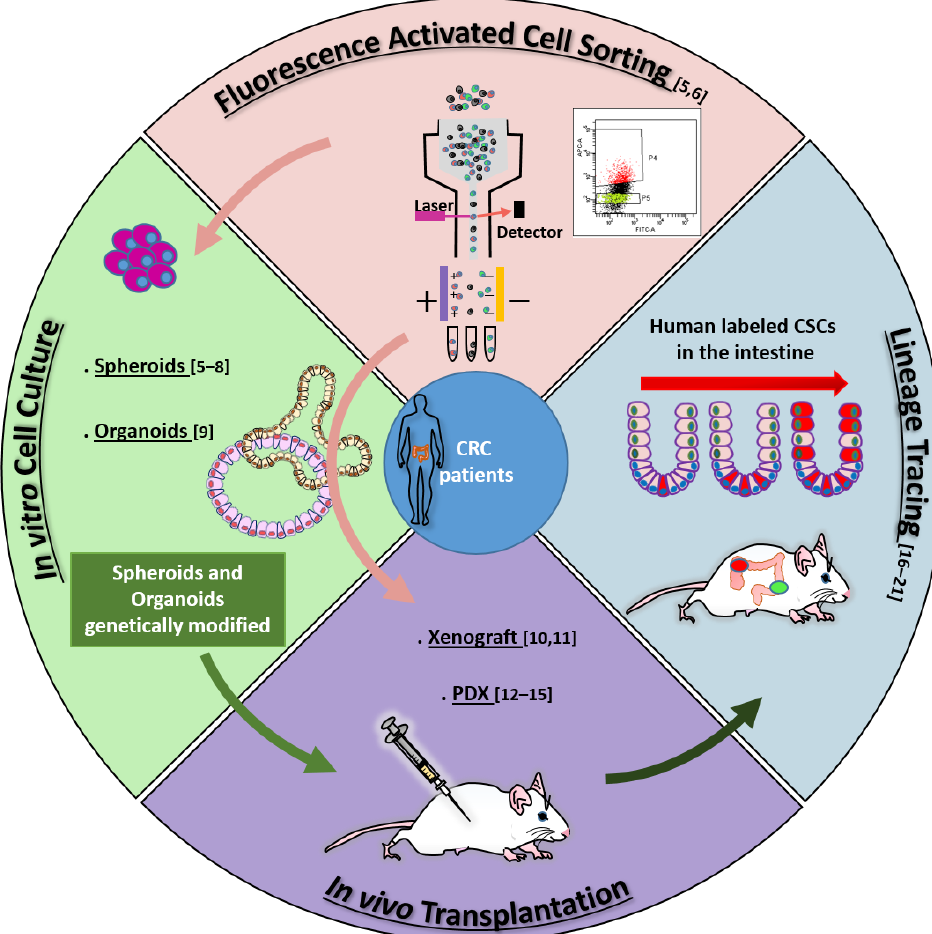
Figure 1. Main methodologies contributing to cCSCs definition: fluorescence-activated cell sorting (FACS) [5,6]; in vitro cell culture [5–9]; in vivo transplantation [10–15]; lineage tracing [16–21]. Ar- rows across sectors identify the complementary application of different techniques: For example, identification of cCSCs by cell sorting can be validated by in vitro cell culture and/or by in vivo trans- plantation assays (pink arrows); Xenografting is often performed with cultured and/or genetically labeled cCSCs (light green arrow); human cCSC lineage tracing is mostly performed by transplanting cCSCs previously genetically manipulated in culture (dark green arrow). Numbers in parentheses indicate references.